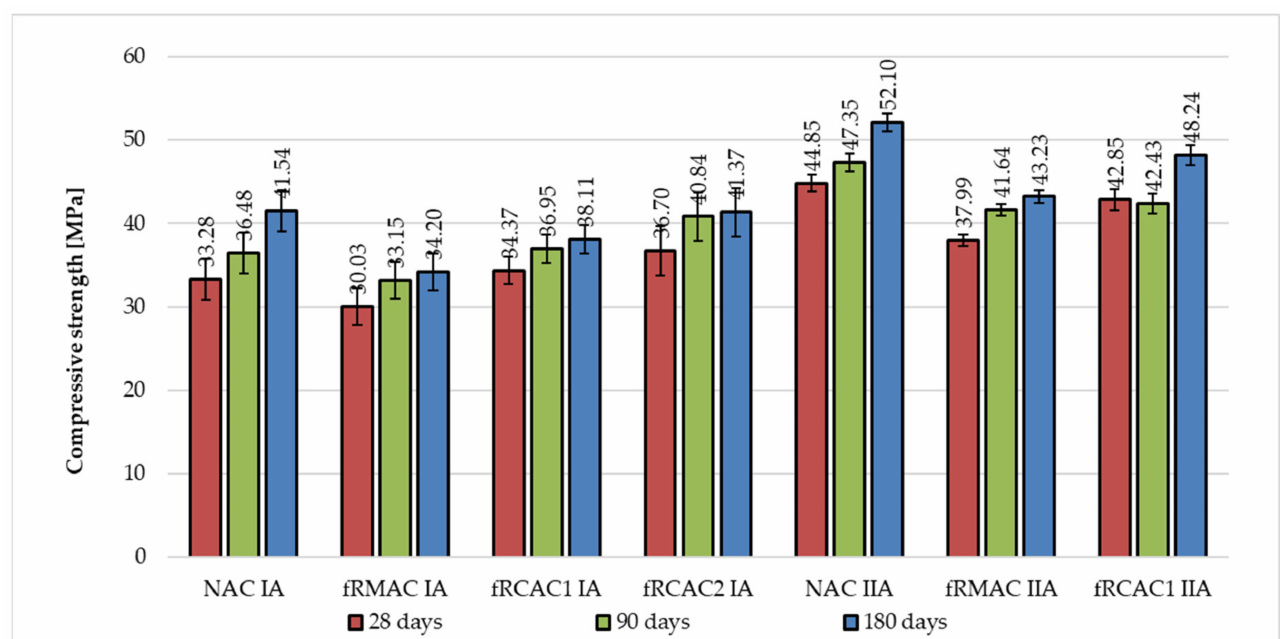
Figure 6. Comparison of long-term development of compressive strength of concrete mixtures